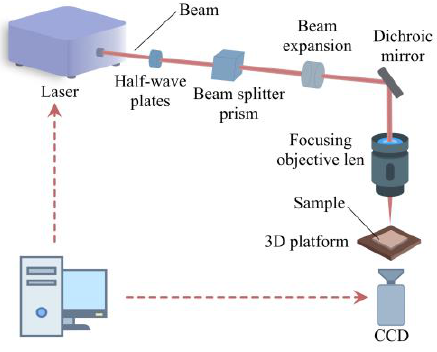
Figure 7. Femtosecond laser processing system.